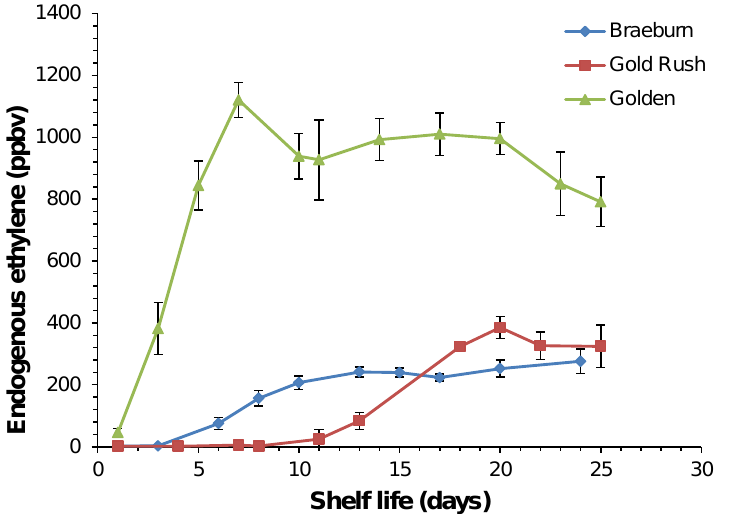
Figure 4. Evolution of endogenous ethylene emission for Breaburn, Gold Rush and Golden Delicious apples during shelf life at 20 °C under ambient air room conditions. Reprinted with permission from [65]. Copyright 2012 Springer Science+Business Media,